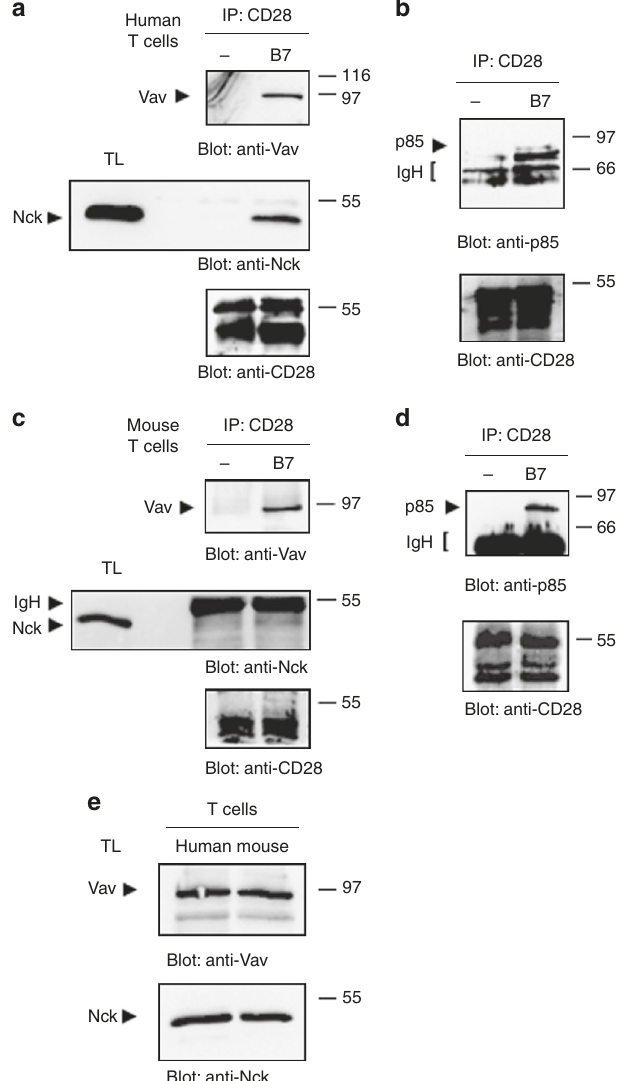
Fig. 5 Nck binds to human but not mouse CD28. a , b Human primary CD4 + T cells were stimulated for 5 min with B7-negative ( − ) or Dap3/B7 (B7) cells and anti-CD28 IP were performed on cellular extracts. Anti-Vav, anti-Nck, anti-p85 PI3K, and anti-CD28 western blottings were performed on anti-CD28 IP or total lysates (TL). Data represent one of three independent experiments. c , d CD4 + T cells isolated from murine spleen ( n = 10) were pooled and stimulated for 5 min with with B7-negative ( − ) or B7.1-expressing RAW (B7) cells and anti-CD28 IP were performed on cellular extracts. Anti-Vav, anti-Nck, anti-p85 PI3K, and anti-CD28 western blottings were performed on anti-CD28 IP or total lysates (TL). The position of immunoprecipitated proteins as well as of immunoglobulin heavy chain (IgH) is indicated. e Equal amounts of total lysates from human or mouse CD4 + T cells were analysed by western blotting for Vav1 (upper panel) and Nck (lower panel) content. The position of molecular weight markers, expressed in kDa, is indicated on the